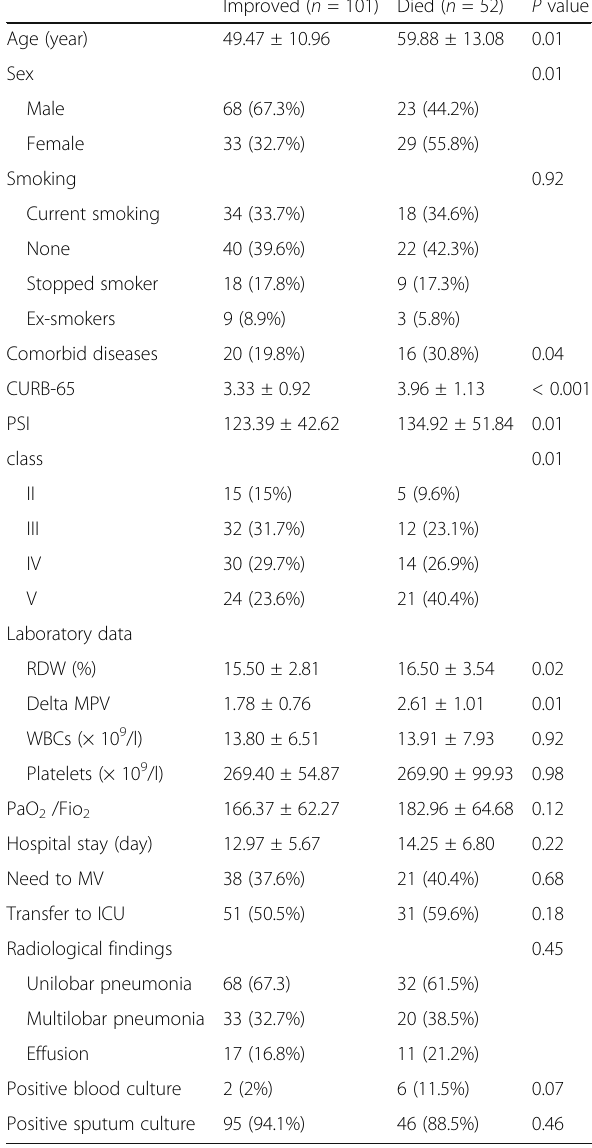
Table 1 Baseline characteristics of both groups Table 2 Correlation between CURB-65 and PSI in correlation